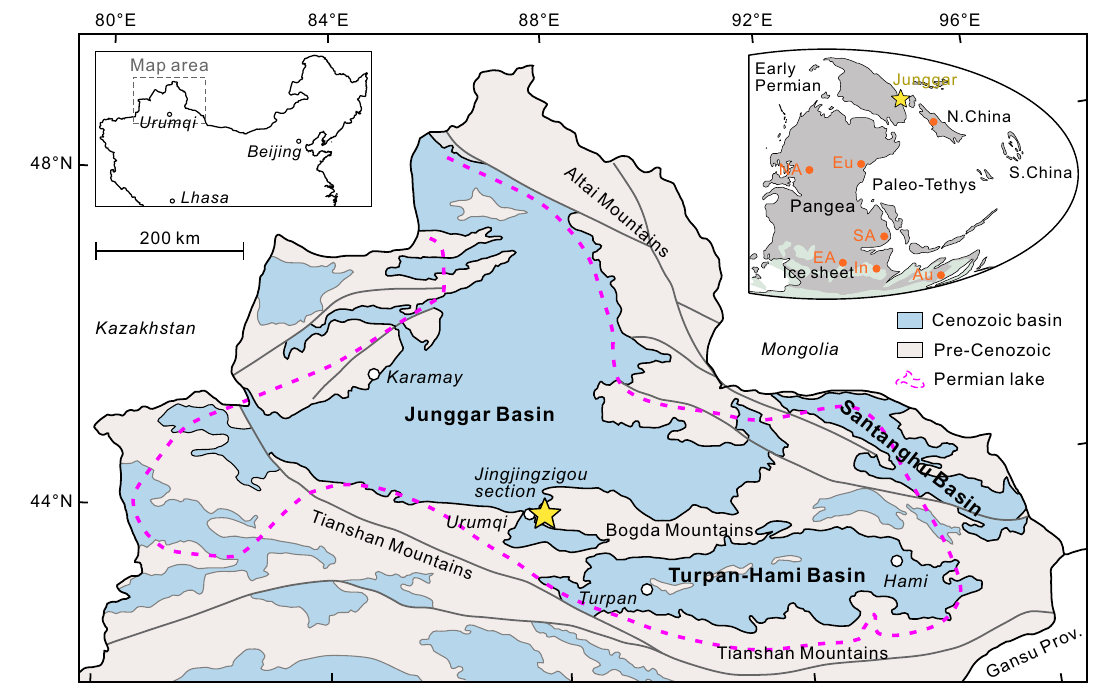
Fig. 1 | Size and location of paleo-Lake Junggar during the Artinskian (Early Permian). The map shows the locations of the Junggar, Turpan-Hami, and San- tanghu basins in northwestern China (modi fi ed from ref. 71), with the maximum known extent of Permian lake deposits marked by the purple dashed line 11 . Yellow star represents the location of the Jingjingzigou section. The Early Permian paleo- geographic map shows the position of Junggar (adapted after Ronald Blakey, https://deeptimemaps.com,sourcemap©2016ColoradoPlateauGeosystemsInc).